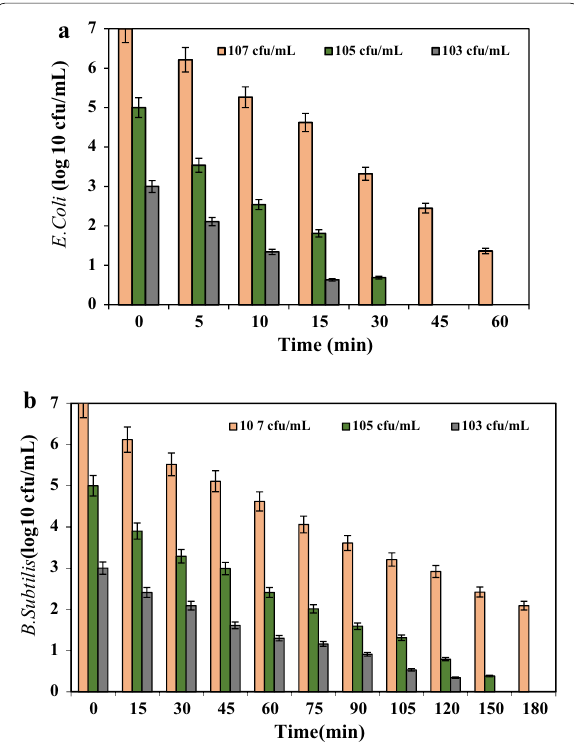
Fig. 4 a Effect of initial bacterial density on E. coli inactivation, b Effect of initial bacterial density on B. subtilis inactivation Fig. 5 a Effect of irradiation on inactivation of E. coli inactivation under the optimal conditions, b Effect of irradiation on inactivation of B. subtilis inactivation under the optimal conditions